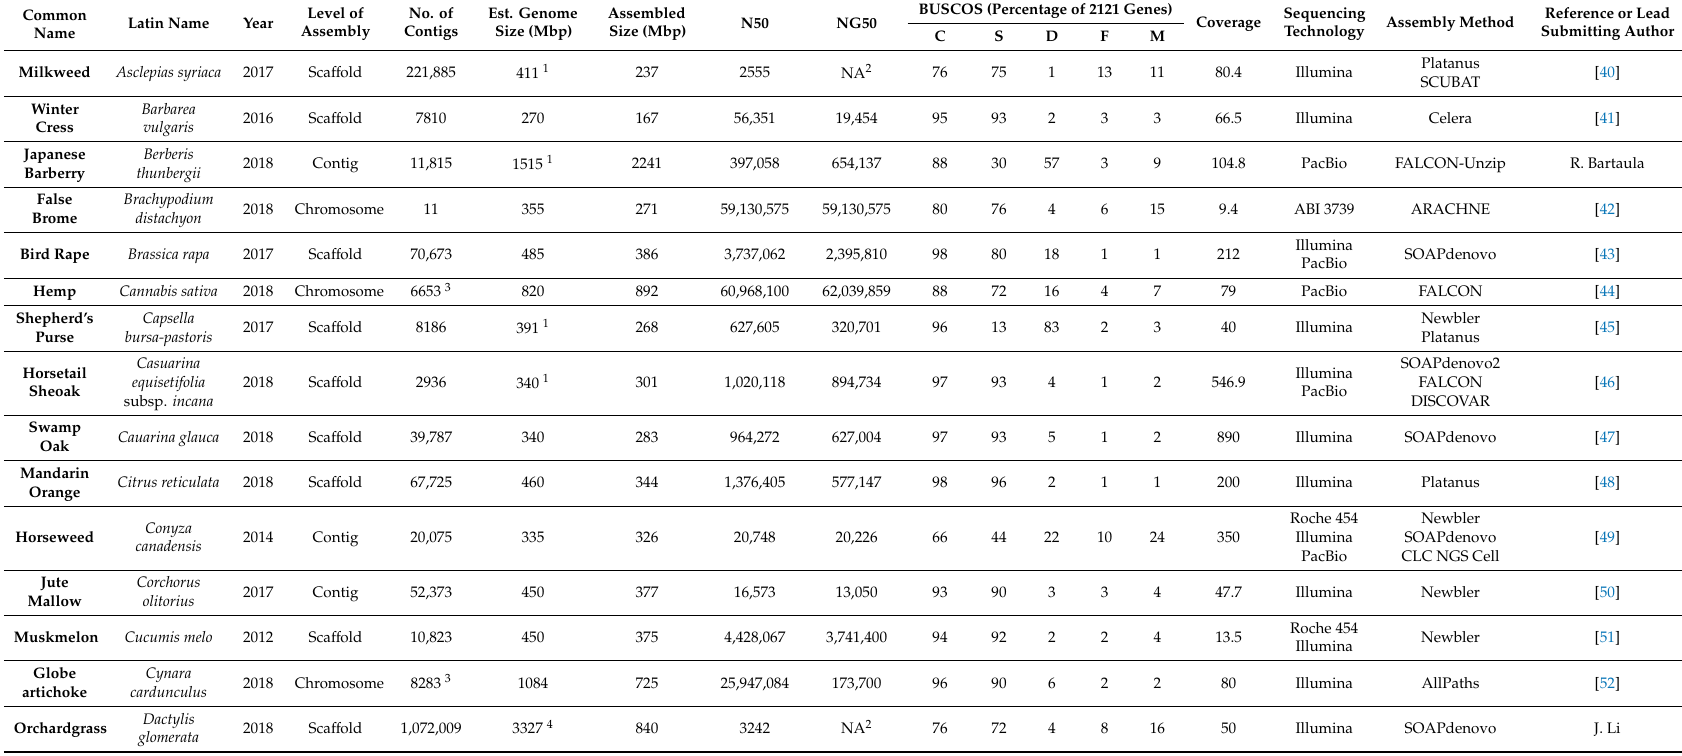
Table 1. Metrics of continuity and completion for weed genome assemblies available from GenBank. This list was compiled by search GenBank [34] in May 2019 for species included on one of the following five lists of weeds: 1) Species with herbicide resistance maintained at weedscience.org by Heap [35], 2) the United States Department of Agriculture’s Federal Noxious Weed List [36], 3) Weeds of Nation Significance in Australia [37], 4) Weber and Gut’s list of weeds spreading in Europe [38], or 5) the Canadian Weed Seed Order [39]. Year is the year the assembly was submitted to GenBank, and as with assembly level, coverage, sequencing technology used and assembly method were recorded from the assembly information page on GenBank. The number of contigs (greater than 500 bp long), assembled genome size, N50 and NG50 were determined by QUAST (v. 5.0.2). The number of BUSCOs that were (C)omplete, complete and (S)ingle-copy, complete and (D)uplicated, (F)ragmented, or (M)issing were determined using the eudicotyledons_odb10 set of 2121 conserved genes and BUSCO version 3.0.2. Where we could not locate a published for the genome, we have reported the lead author as listed as having submitted the genome to GenBank. Note that additional weed genomes may be available on CoGe, Phytozome, and the European nucleotide